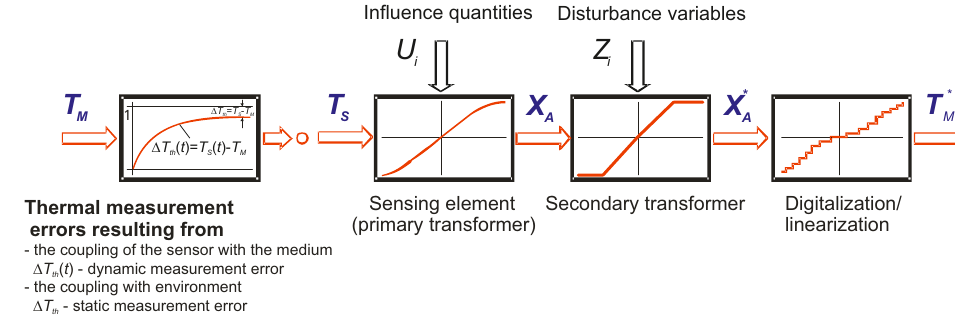
Figure 1. Representation of the contact thermometer as a measuring chain (Augustin et al., 2017).